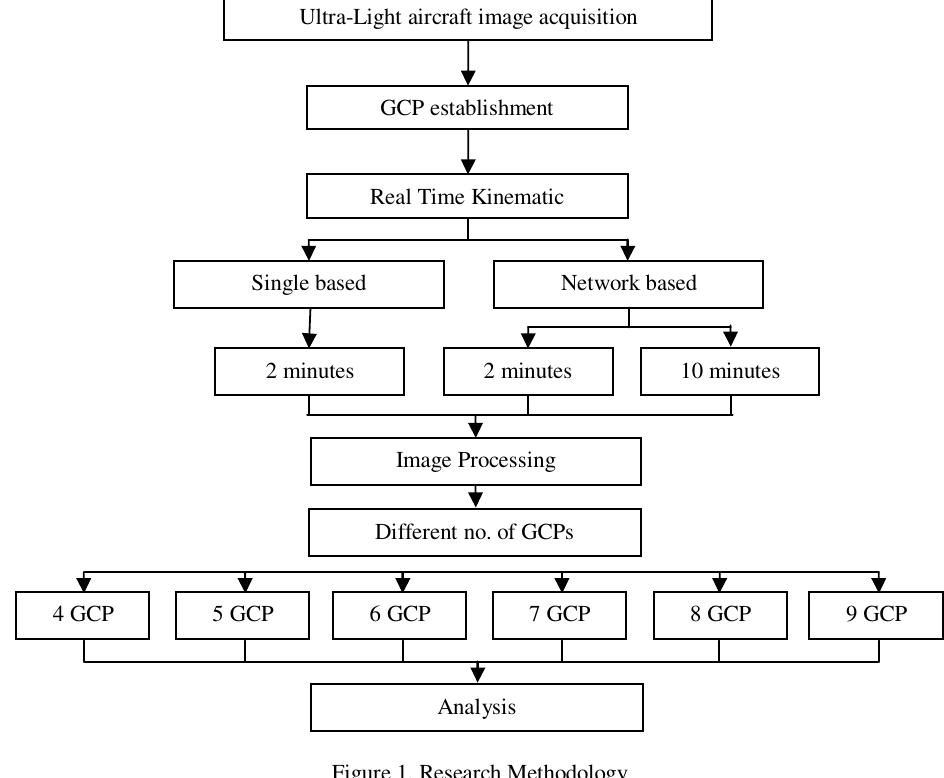
Figure 1. Research